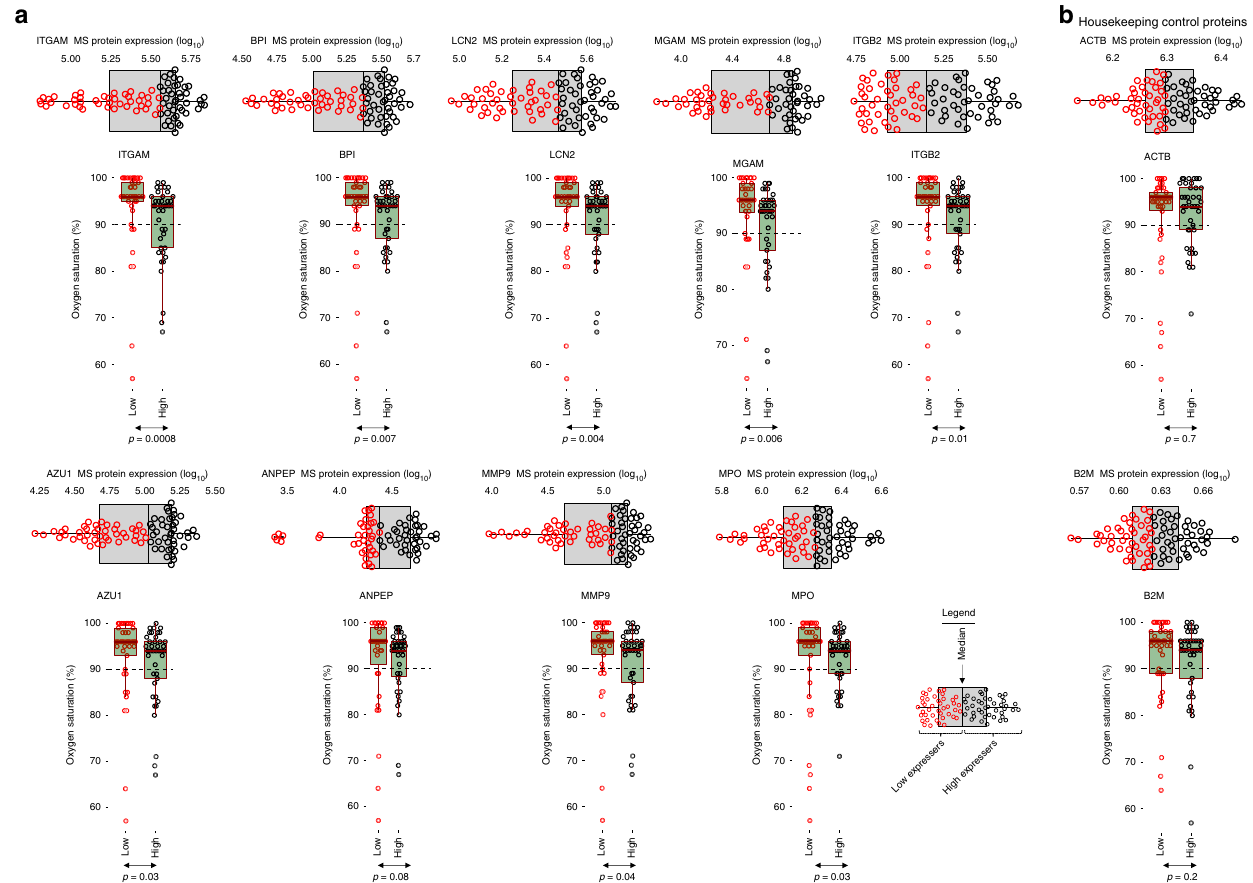
Fig. 5 Association between airway neutrophil granule expression and disease severity. In order to characterise the clinical implications of the increased expression of neutrophil-associated proteins on disease pathology, we assessed the association between the level of expression of these proteins and a cardinal feature of RSV pathology, blood oxygen saturation. a Using proteome data obtained from all admitted children ( n = 84), we strati fi ed the expression levels of nine neutrophil granule proteins (ITGAM, BPI, LCN2, MGAM, ITGB2, AZU1, ANPEP, MMP9 and MPO) that were signi fi cantly over- expressed in RSV-infected children by the median. Children whose protein expression level was above the population median were classi fi ed as high- expressers while those below it were classi fi ed as low expressers (see legend for graphical illustration of the strati fi cation strategy). For all proteins analysed, children in the high expression group had signi fi cantly lower blood oxygen saturation levels (measured using fi ngertip pulse oximetry) compared to children in the low expression group. b For comparison, we used the same median strati fi cation strategy to dichotomise children into high and low expression groups for two housekeeping control proteins, beta-actin (ACTB) and beta-2-microglobulin (B2M). For both proteins there was no statistically signi fi cant difference in blood oxygen saturation levels between high and low expressers. The dashed horizontal line indicates an oxygen saturation threshold of 90%, below which children would typically be characterised as functionally hypoxic. Statistical comparison between high and low strata was done using a two-sided Student t -test. The elements of the box and whisker plots are de fi ned in Fig. 1. Source data are provided as a Source Data (B2M) — using the median. In contrast to the neutrophil granule